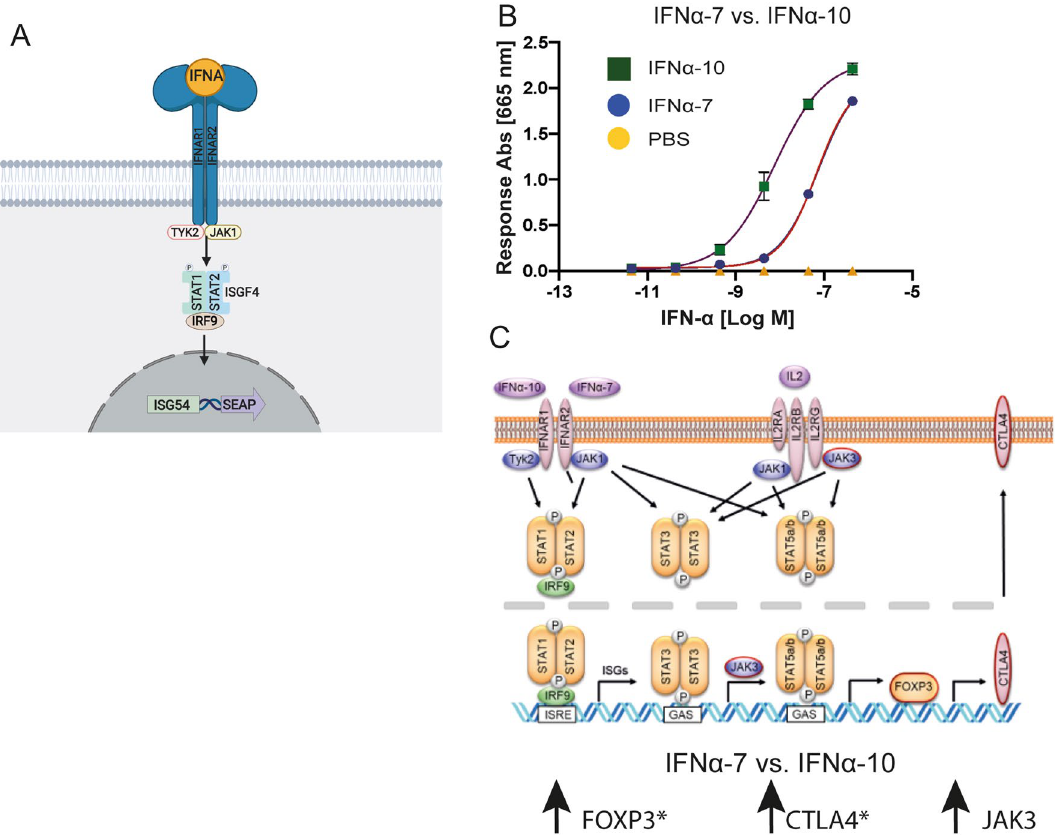
Figure 5. Suggested model of IFNα-7 vs IFNα-10 strengthens difference in ISG transcription signaling. ( A ) Schematic representation of HEK293 reporter cell line for IFNAR1/2 mediated JAK STAT1/2 signaling leading to ISG transcription of secreted embryonic alkaline phosphatase. ( B ) Dose–response curves of HEK293 reporter cell line upon treatment with either IFNα-7 (blue circles) or IFNα-10 (green squares), SEM error bars based on n = 2, duplicate measurements and subtracted baseline signal (PBS). ( C ) A pathway map showing signaling pathways for the IFNAR1/IFNAR2 receptor and the IL-2 receptor. Genes in red are upregulated when comparing IFNα7-treated versus IFNα10-treated cells. JAK3 is significantly upregulated (FDR < 0.05 and > twofold upregulation). * indicates additional phenotypic readouts at a protein level in the primary assay. The observed differences between IFNα-7 and IFNα-10 are further discussed in the main